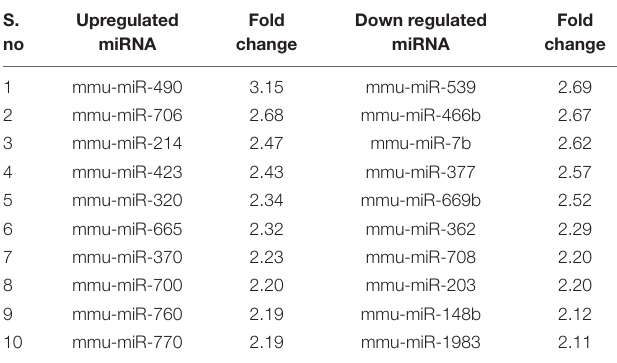
Frontiers in Molecular Neuroscience |